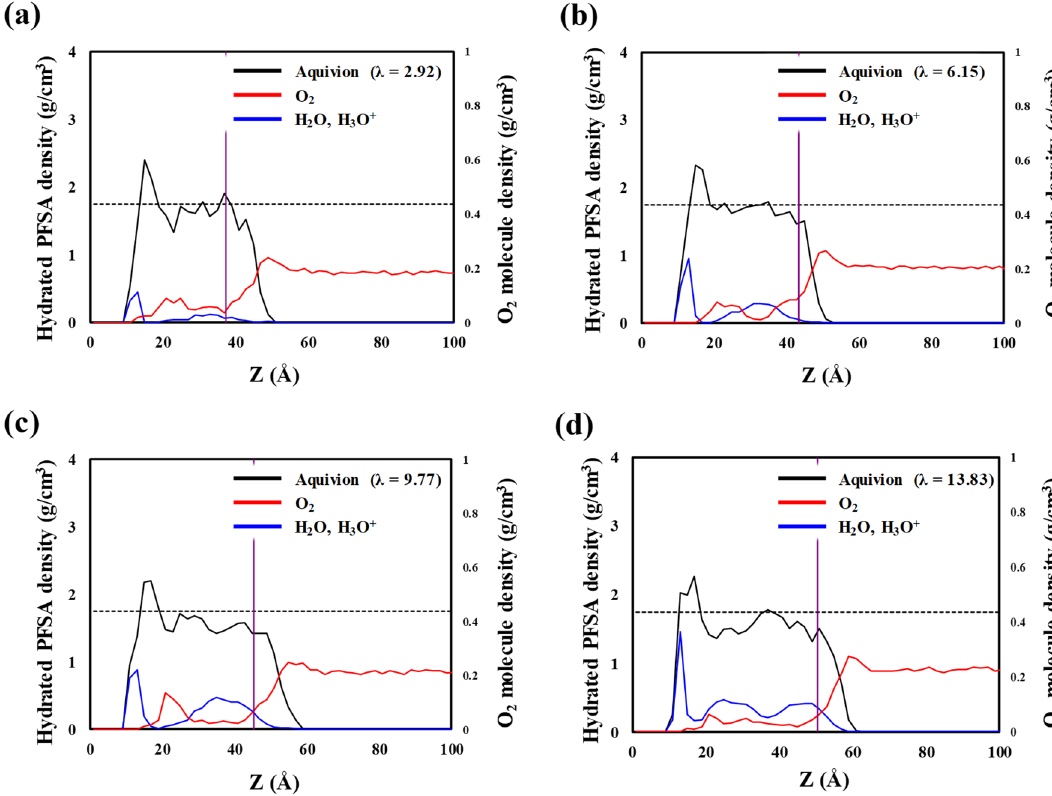
Figure 5. Density distributions of hydrated Aquivion ionomer (with included water and hydronium ions; black lines), water and hydronium ions (blue lines), and O 2 molecules (red lines) on the Pt (111) surface along the thickness direction, with λ values of ( a ) 2.92, ( b ) 6.15, ( c ) 9.77, and ( d ) 13.83. Dashed lines show the previously reported density for hydrated bulk Aquivion 20 . The purple line indicates the point of O 2 solvation occurs from the interface of gas/hydrated Nafion.